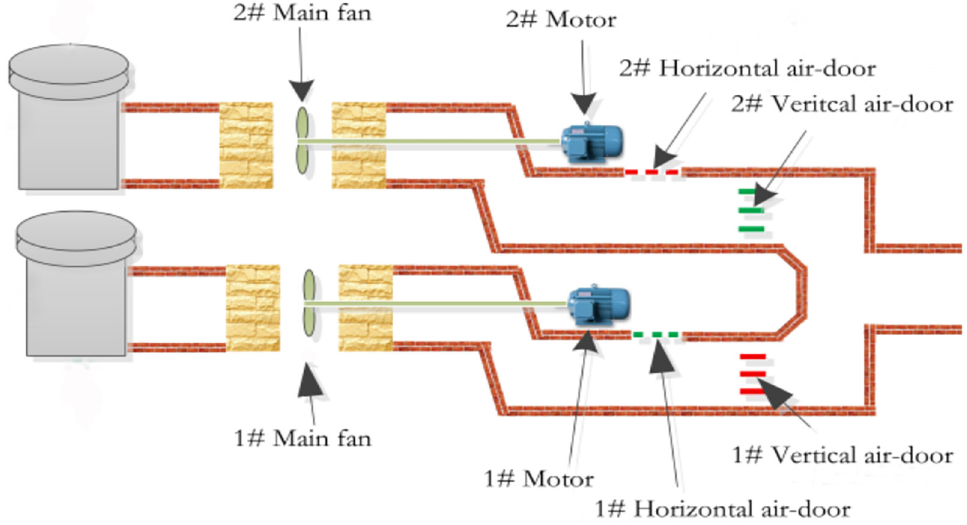
Fig. 1. Structure of mine main fans switchover system.